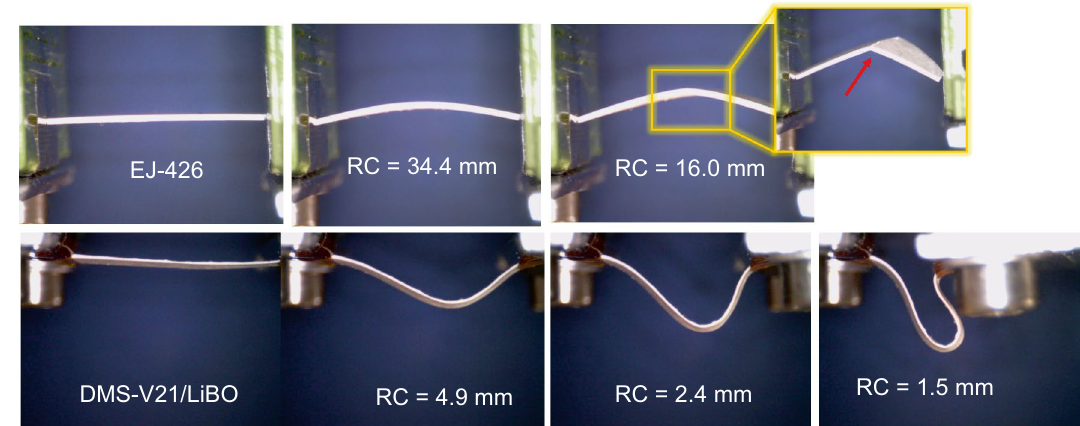
Figure 5. Pictures of the commercial scintillator EJ-426 (top row) and the ZnS:Ag/LiBO/PDMS detector (bottom row) clamped in a vice and bent at decreasing curvature